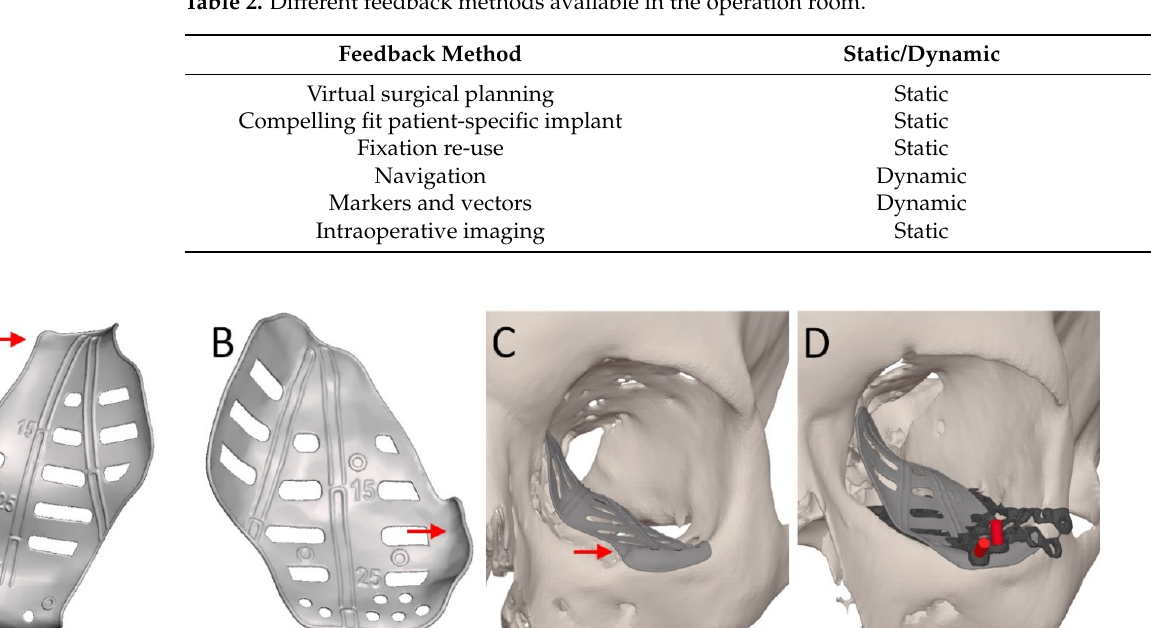
Figure 8. Illustration of an evaluation. ( A ) Three-dimensional model of the planned patient-specific implant (red) and the realized patient-specific implant (green) viewed from different perspectives. ( B – D ) Axial, sagittal, and coronal view of the postoperative computed tomography scan with the planned contour of the patient-specific implant in red.